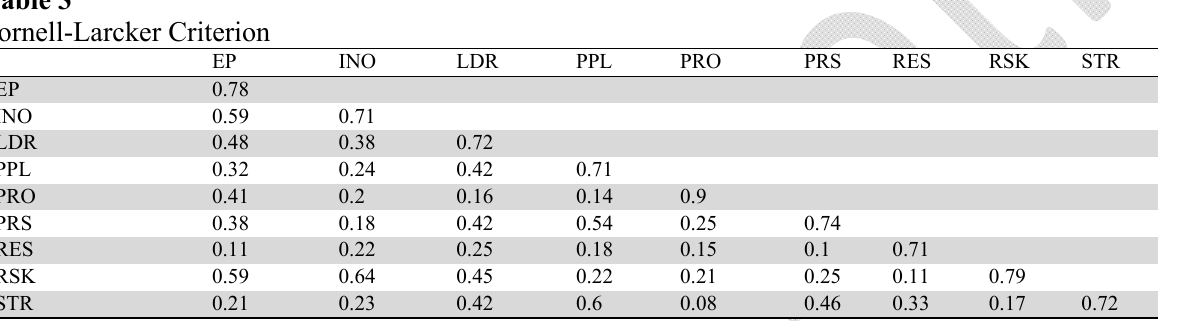
Fornell-Larcker